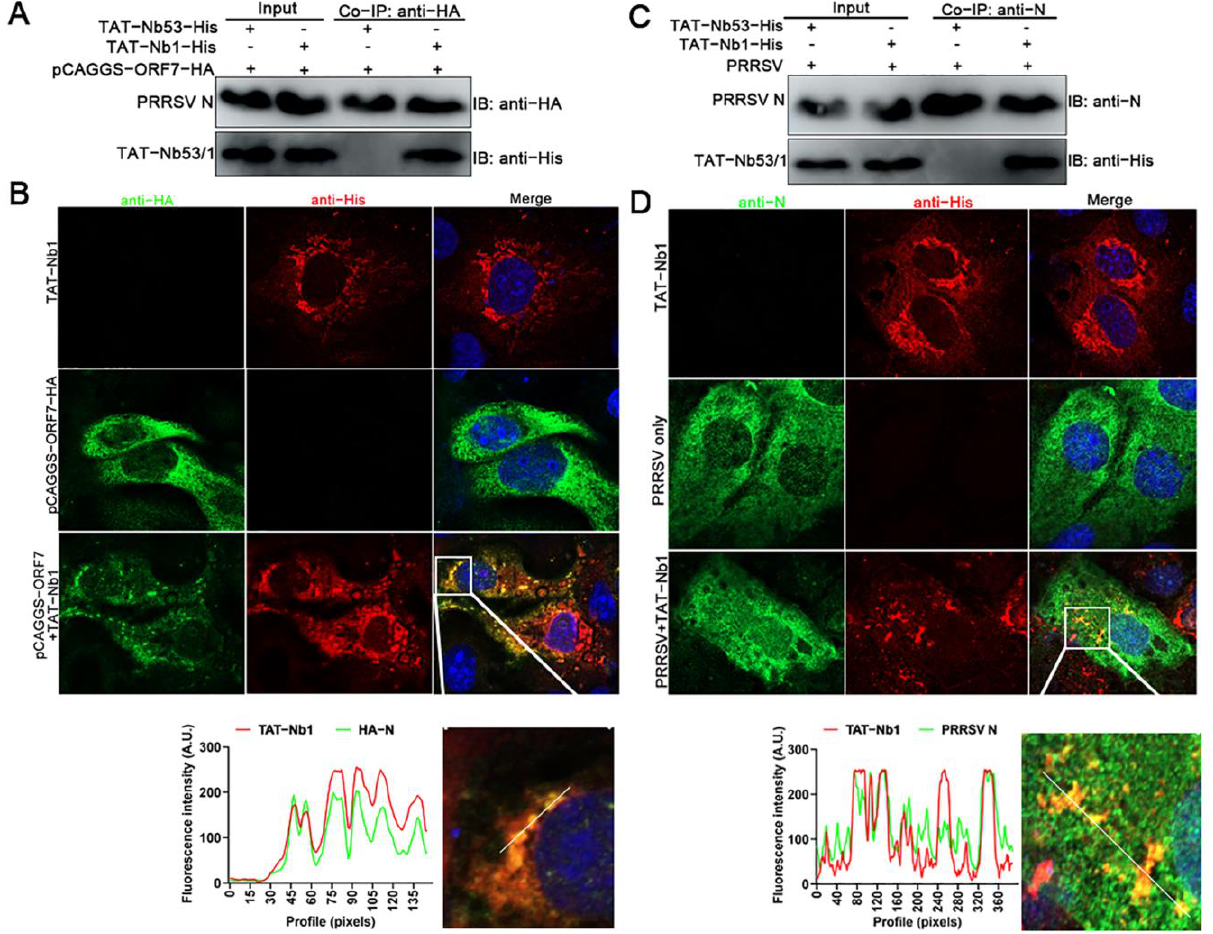
Figure 3. TAT - Nb1 interacts with PRRSV N Protein. Marc - 145 cells seeded in 6 - well plates were Figure 3. TAT-Nb1 interacts with PRRSV N Protein. Marc-145 cells seeded in 6-well plates were treated with 20 μM TAT - Nb1 for 6 h and then transfected with 1.5 μg of pCAGGS - ORF7 - HA for treated with 20 µ M TAT-Nb1 for 6 h and then transfected with 1.5 µ g of pCAGGS-ORF7-HA for another 24 h. Cells were harvested for co - IP analysis ( A ), and partial cells were fixed and analyzed another 24 h. Cells were harvested for co-IP analysis ( A ), and partial cells were fixed and analyzed using confocal ( B ). Marc - 145 cells seeded in 6 - well plates were incubated with 20 μM TAT - Nb1 for using confocal ( B ). Marc-145 cells seeded in 6-well plates were incubated with 20 µ M TAT-Nb1 for 6 h and followed by infection with 0.1 MOI of PRRSV for 24 h. Cells were collected for TAT-Nb1 and N protein interaction analysis using co-IP ( C ) and confocal ( D ), respectively. Scale bar = 20 µ